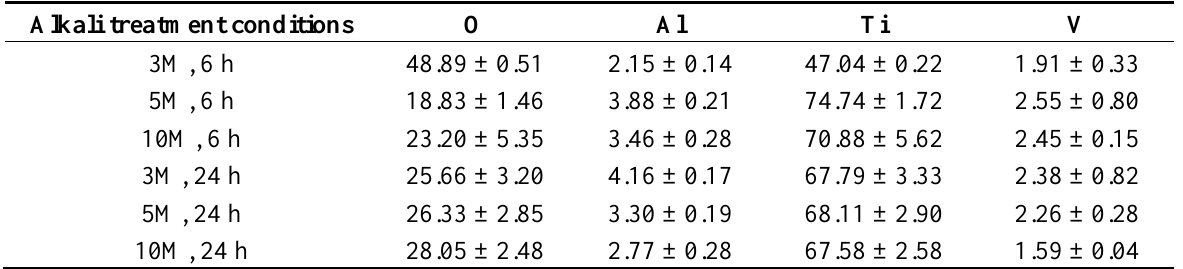
Table 2. EDS elemental analysis (wt. %) of AlAcH treated samples for various alkali concentrations and immersion